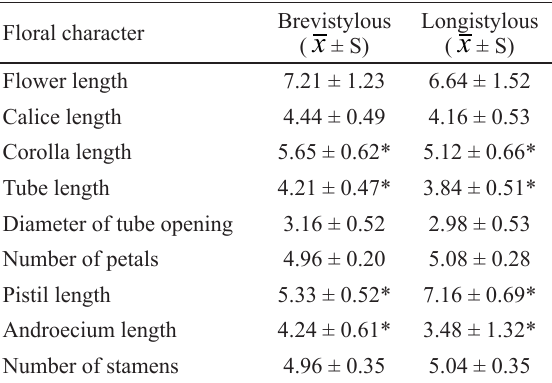
Average (mm) and standard deviation (S) of floral characters of Varronia curassavica Jacq. in a sandbank environment, Joaquina, Florianópolis, Santa Catarina, Brazil ( n = 50).